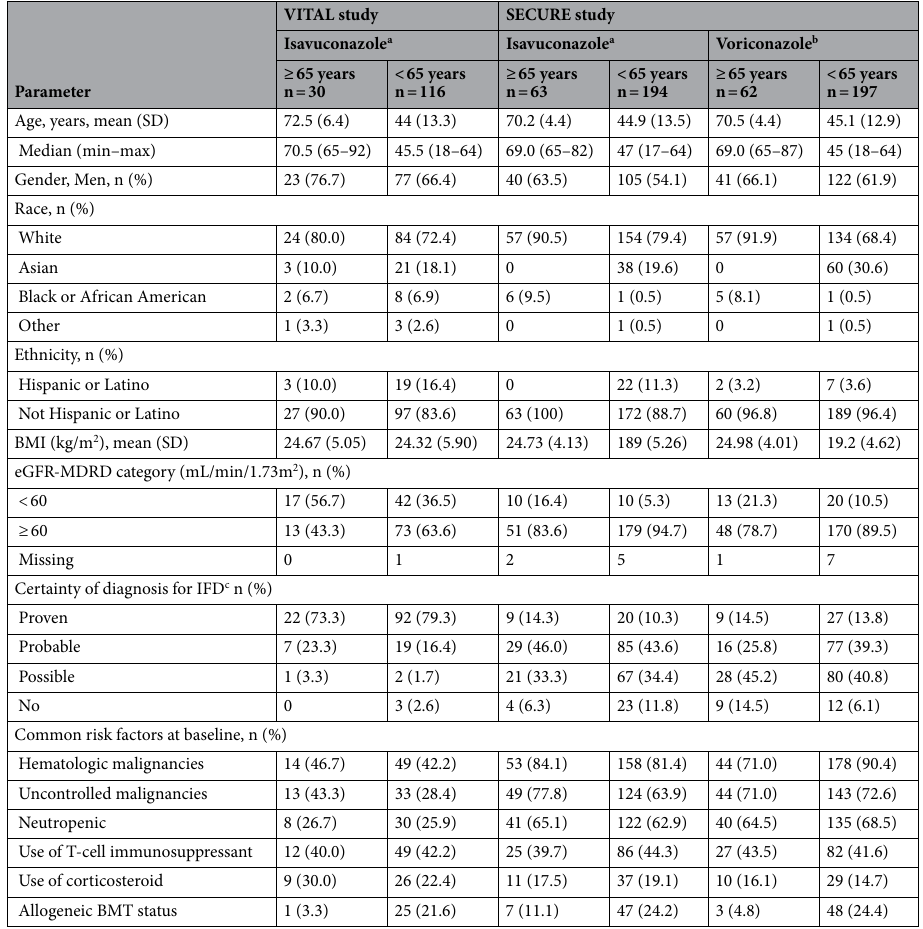
Table 1. Demographic and baseline characteristics (safety population). Allogeneic BMT status was defined as Yes for patients who were noted as having a BMT and Allogeneic for type of transplant on the primary underlying disease or condition. Uncontrolled malignancy status was defined as Yes for patients who had a malignancy diagnosis and New diagnosis/Active disease/Relapse present. BMI body mass index, BMT bone marrow transplant, DRC data review committee, eGFR-MDRD estimated glomerular filtration rate calculated using the modification of diet in renal disease formula, SD standard deviation, n number of patients. a Patients received either oral or intravenous isavuconazole 200 mg every 8 h for six doses, followed by a once-daily dose. b Voriconazole was administered intravenously as 6 mg/kg twice daily on day 1, 4 mg/kg twice daily on day 2, and 4 mg/kg or orally as 200 mg twice daily from day 3 onwards. c Categorized as per the IFD assessment by